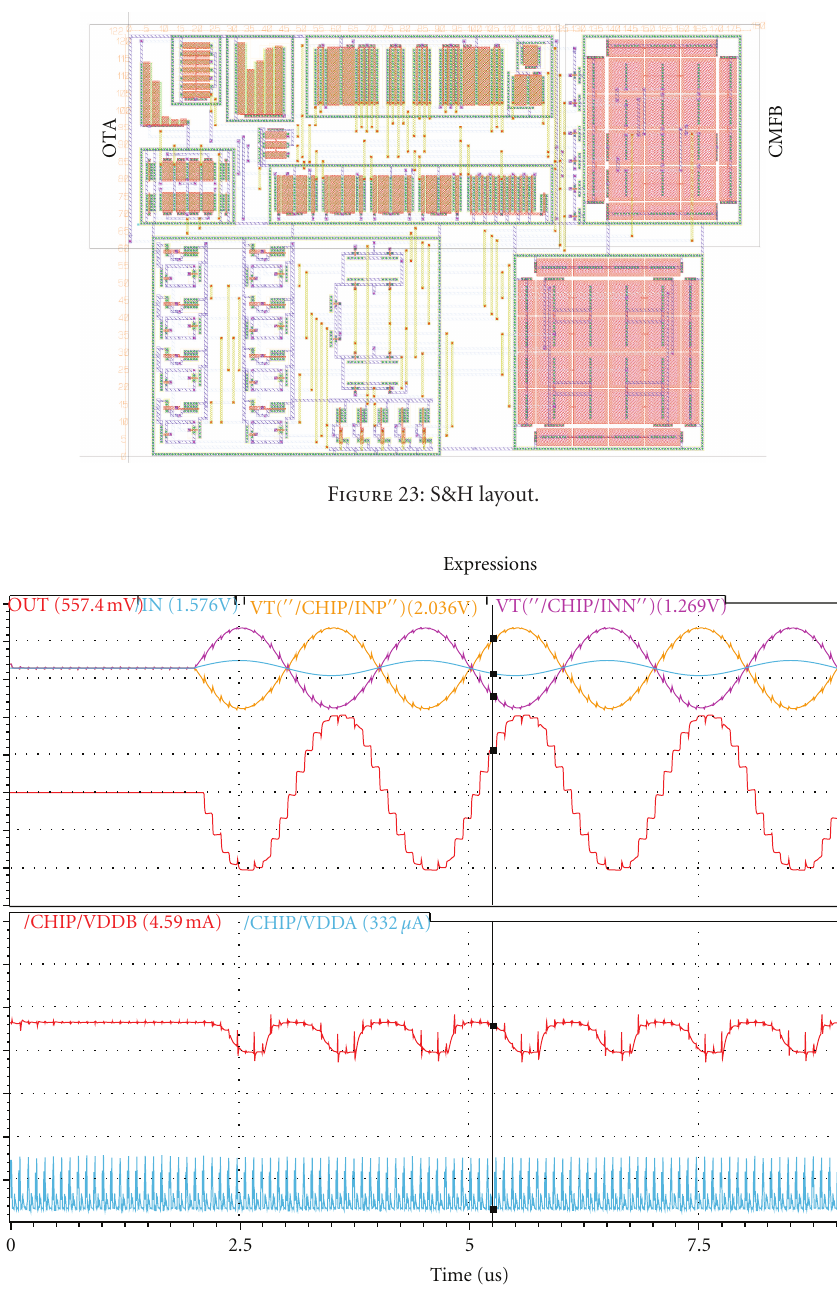
Figure 24: S&H postlayout